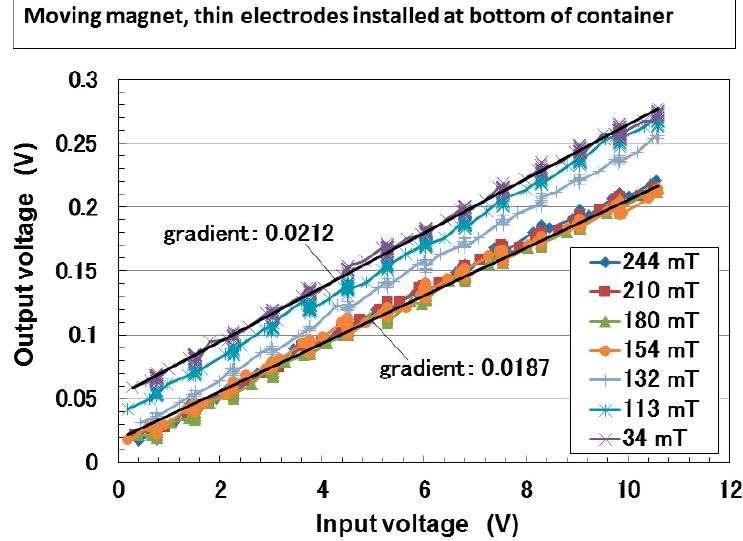
Figure 14. Relation between input and output voltage at a position of the magnet from the bottom of the container for a moving magnet and with electrodes installed at the bottom of the container.